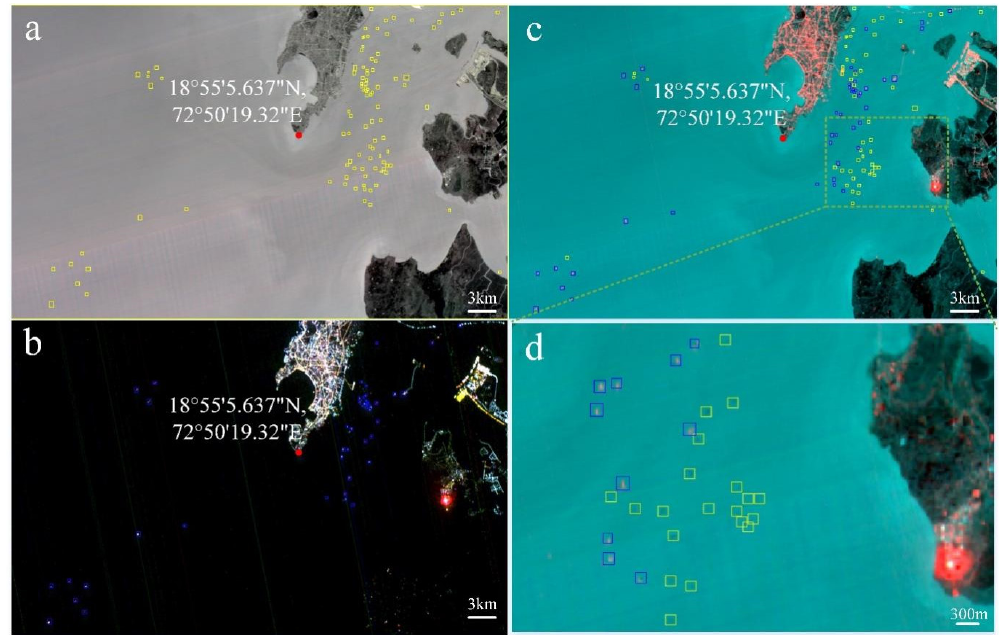
Figure 12. Night images in Mumbai, India with ( a ) thermal infrared image of 11.5–12.5 µm, 8–10.5 µm, and 10.3–11.3 µm at night (The positive ship detection results are marked in yellow boxes), ( b ) glimmer image of R:615~690 nm, G:520~615 nm, and B:430~520 nm at night (The observed ships are marked in blue boxes), ( c ) fusion image of 0.615~0.69 nm, 8~10.5 µm, and 10.3~11.3 µm with